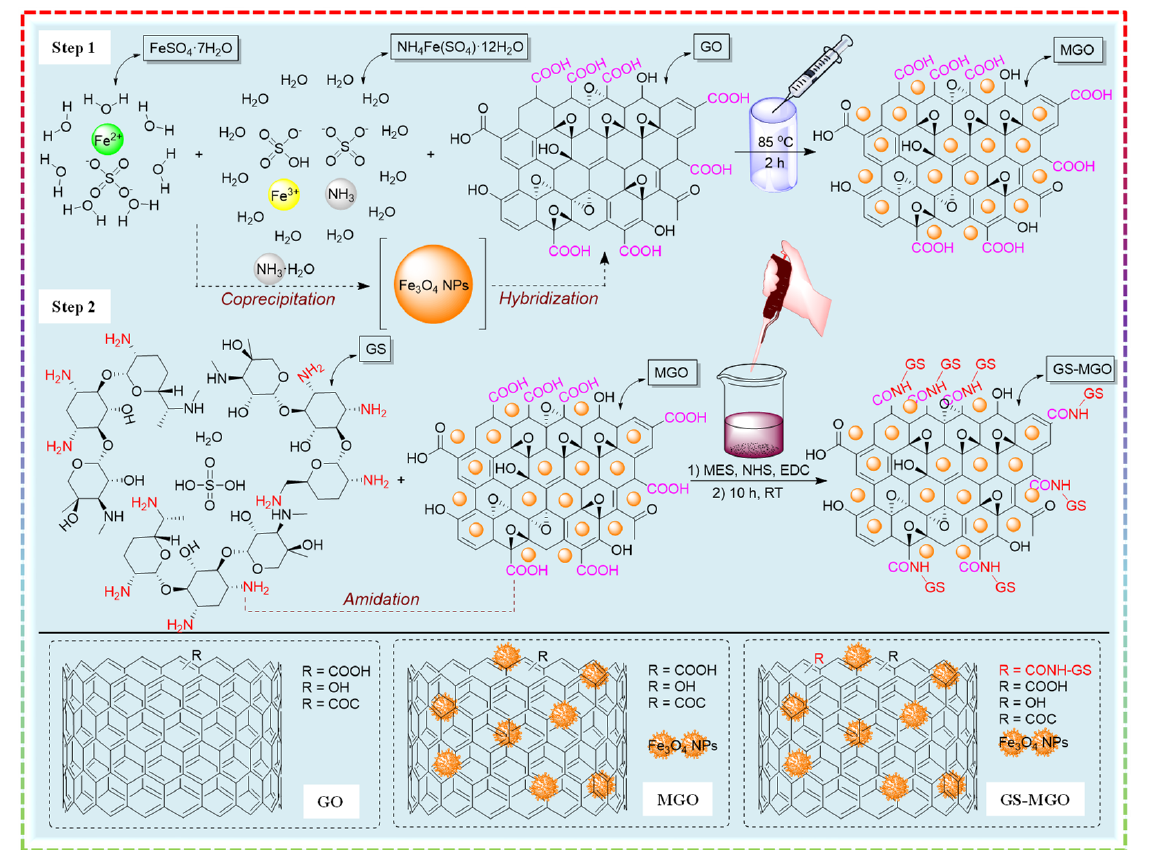
Figure 1. Schematic diagram of the preparation process of the GS − MGO nanohybrids. A total of 0.1 g EDC and 0.2 g NHS were taken to 0.1 M MES buffer solution (pH = 5.5) and stirred for 10 min. Then, 0.1 g GS and 0.1 g MGO were added and stirred for 10 h, followed by centrifugation at 10,000 rpm for 10 min and washing with DI water